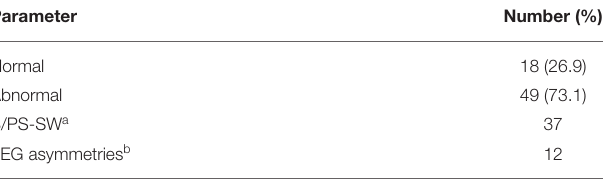
TABLE 3 | EEG findings in JME patients.